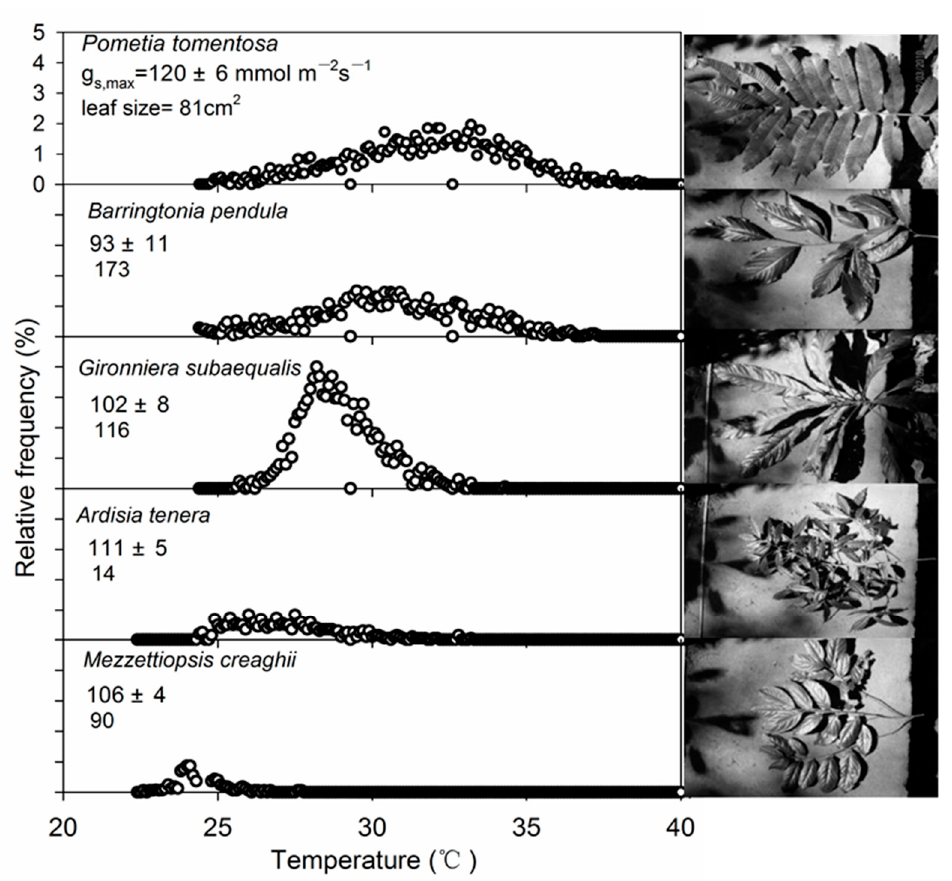
Figure 3. Leaf temperature distributions of the five tree species showed (photos). Maximum g s and leaf size values are inserted.